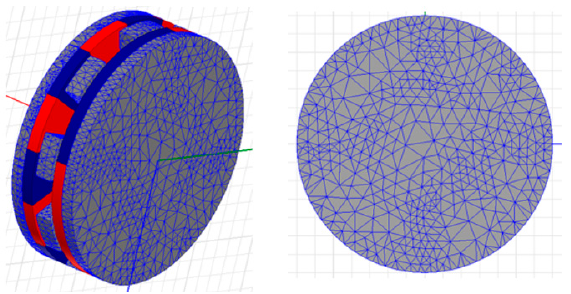
Figure 8. The 3D-FEA magnetostatic model mesh plot of the AFMG.